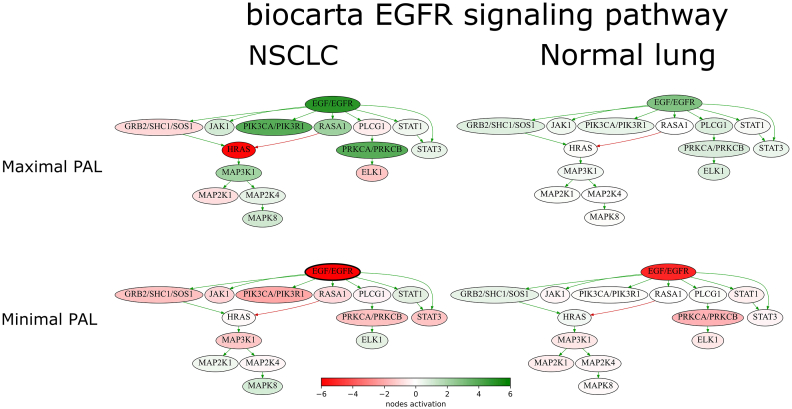
EGFR pathway (Biocarta) shown as an interacting network for samples with maximal (top) or minimal (bottom) PAL in colorectal cancer (left) vs normal colon (right). Green/red arrows indicate activation/inhibition interactions, respectively. The color depth of transcript nodes reflects the extent of node activation (logarithms of the expression fold change for each node, the reference is the geometric average between expression levels in all samples in the respective groups). Visualized using Oncobox software.